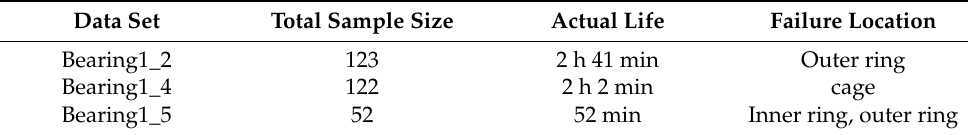
Table 1. Bearing data